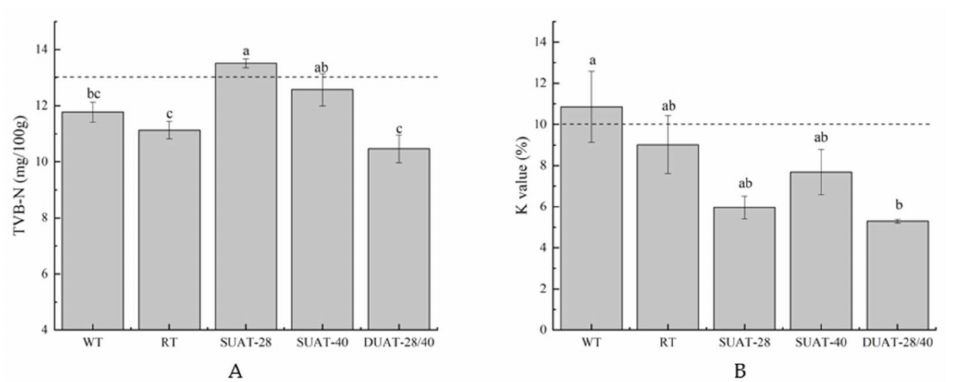
Figure 4. Differences in TVB-N value (mg/100 g) ( A ) and K value (%) ( B ) of large yellow croaker under different thawing methods. (WT: water thawing; RT: refrigerated thawing; SUAT-28: single- frequency ultrasound-assisted thawing at 28 kHz; SUAT-40: single-frequency ultrasound-assisted thawing at 40 kHz; DUAT-28/40: dual-frequency ultrasound-assisted thawing at 28 kHz and 40 kHz). Different superscript letters indicate significant difference ( p <